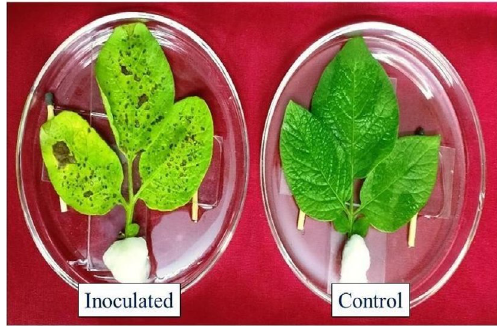
Fig. 1. Pathogenicity test: Leaves detached from plants 1 week after